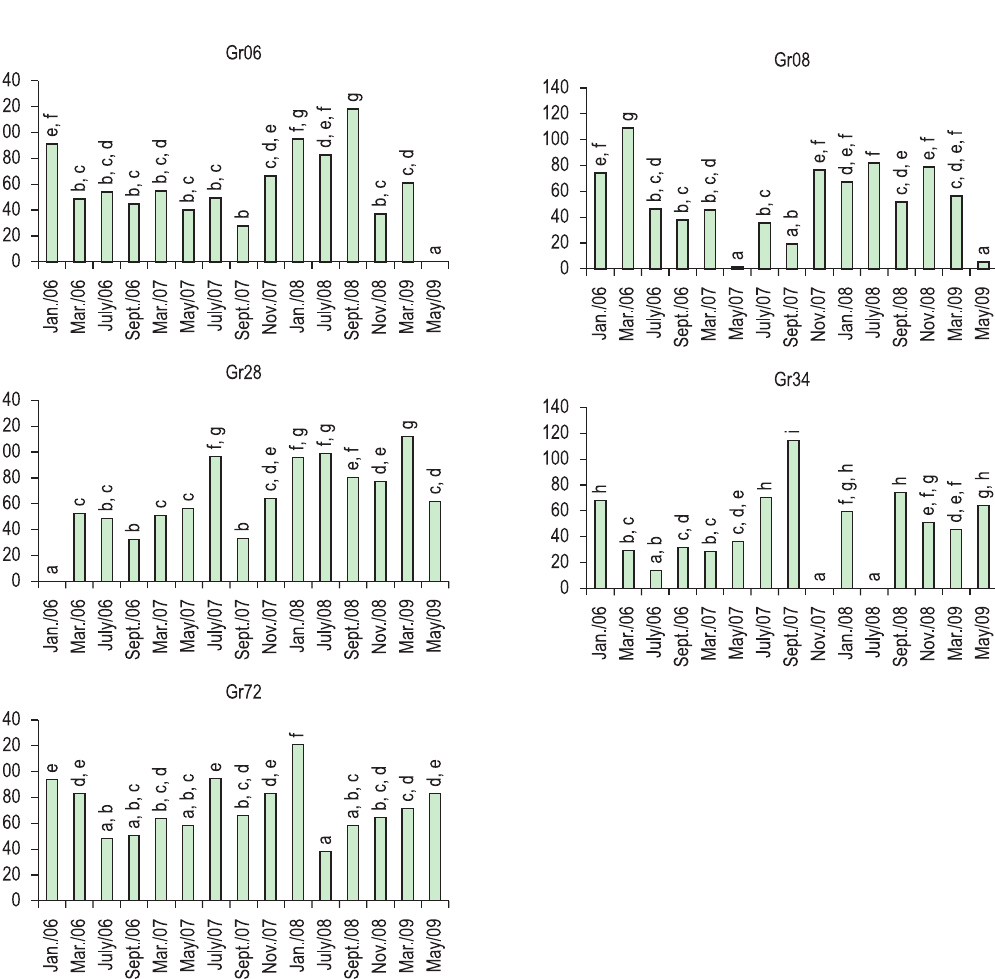
Figure 4. Difference in births between the control group and the samples.